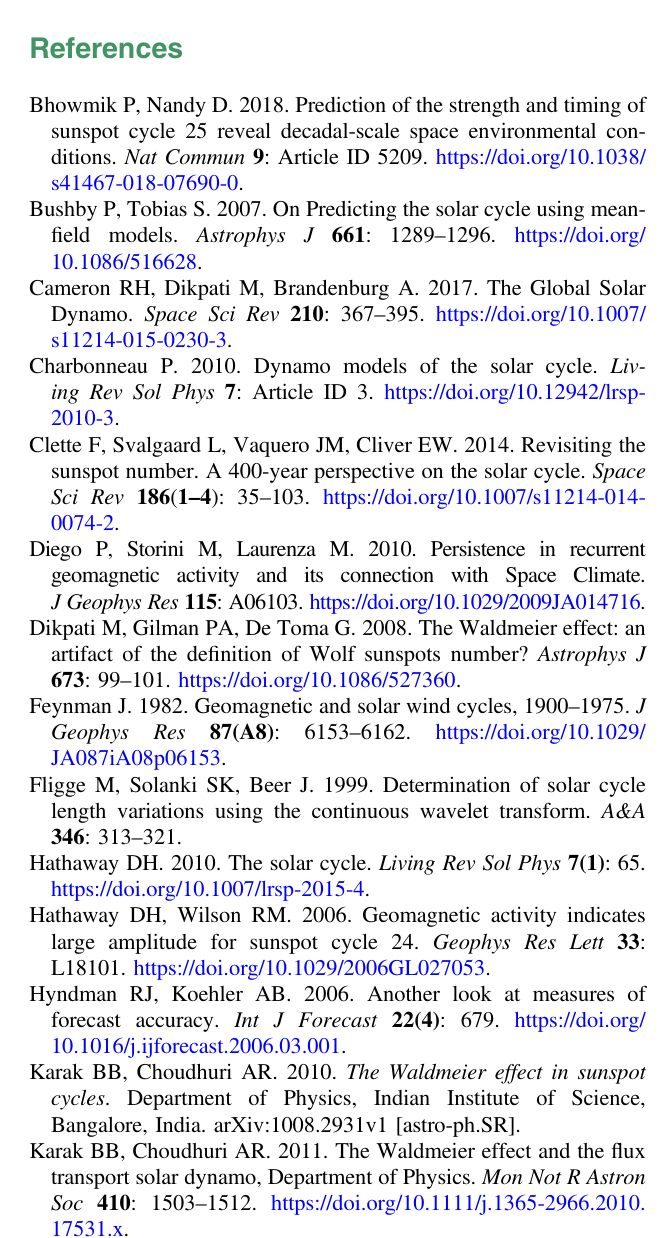
Fig. 5. Monthly SN since solar cycle 12 (blue line) along with I 6 [ aa ] (grey line). The cycle 25 pro fi le (red line) is obtained with the predicted values of maximum peak and growth rate from regressions in Figures 2 and